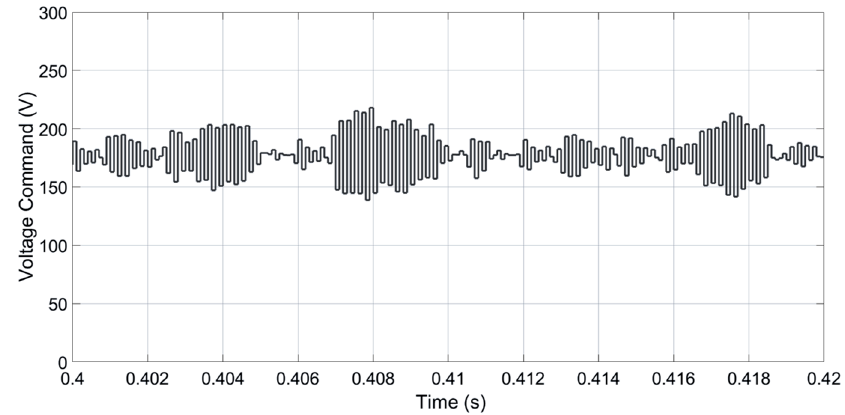
Figure 11. Voltage command for proposed rSVM-DTC (10 kHz).